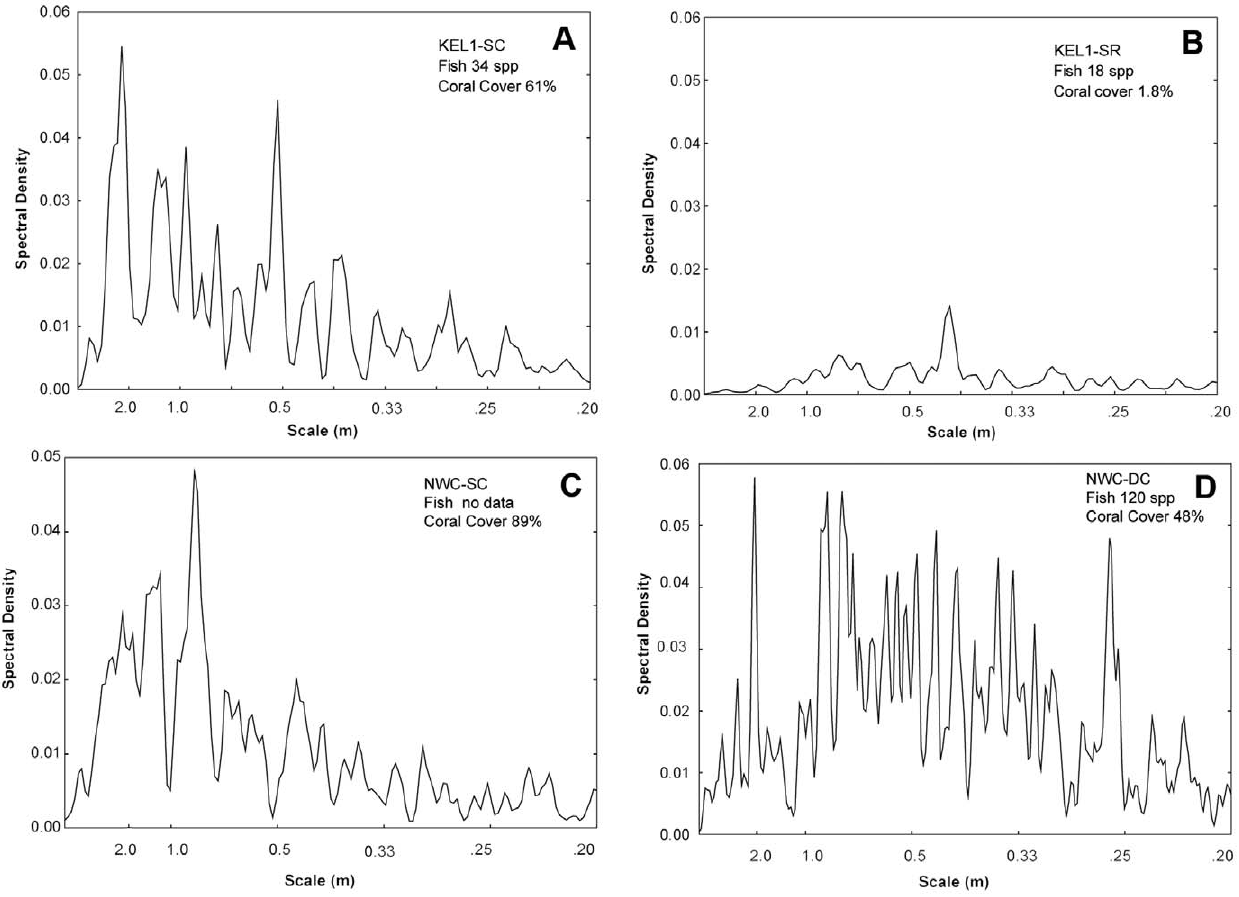
Figure 5. Scale of structural complexity revealed by Fast Fourier analysis of DRR. Spectral Density plots of DDR transects at Kelor Point (3– 5 m) for a rich coral transect at KEL1-SC (A) and adjacent rubble site at KEL1-SR (B). Periodograms C and D characterize transects at Northwest Corner for rich coral cover in shallow (NWC-SC, 3 m) and deeper (NWC-DC, 9 m).